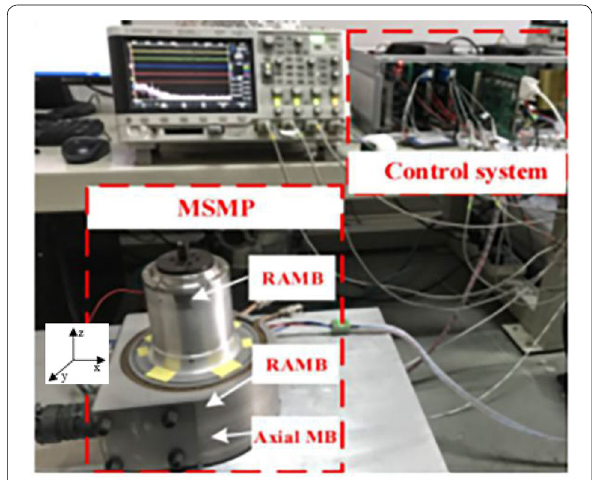
Figure 9 Measurement test system